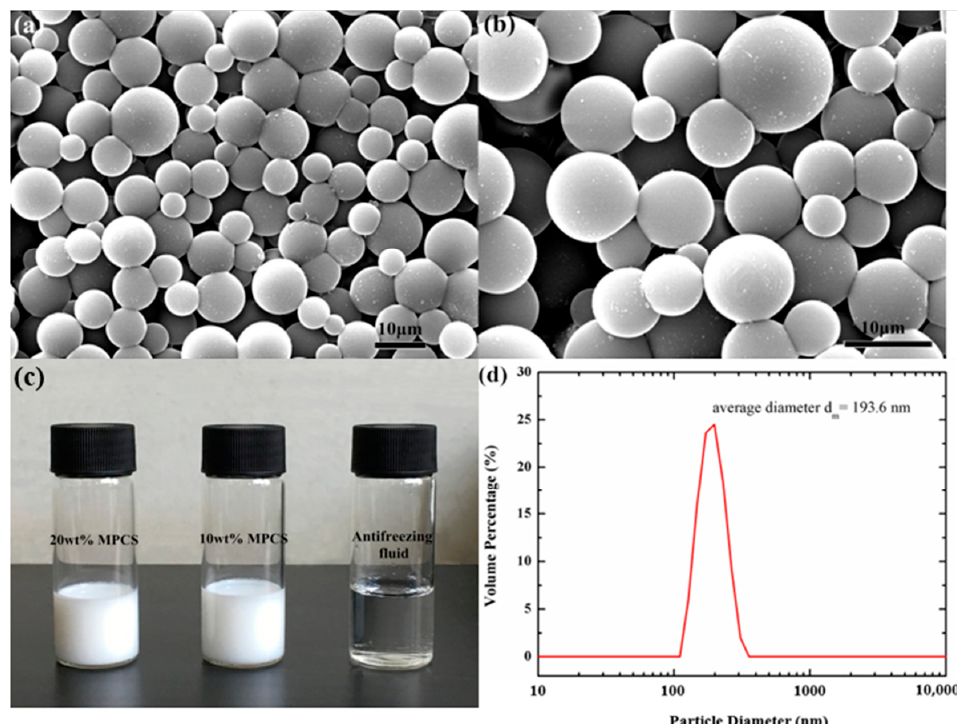
Figure 4. The SEM images of 1 wt% MPCS under different magnification: ( a ) 1:1300 ( b ) 1:2200. The photographs of ( c ) three liquids and particle size distribution of ( d ) 10 wt% MPCS.